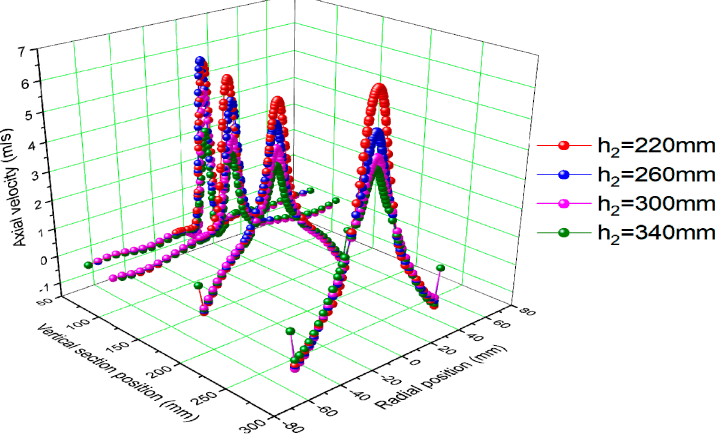
Figure 9. Distribution curve of axial velocity.